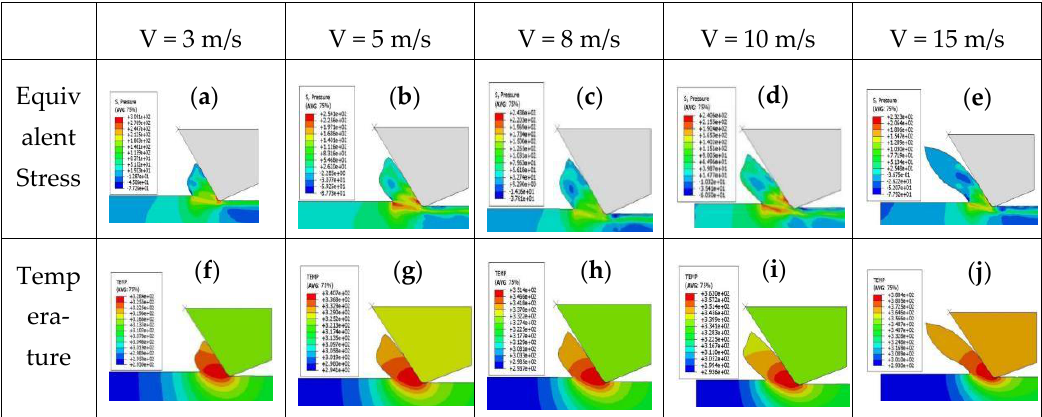
Figure 8. Stress distribution and temperature distribution of KDP crystal at different cutting speeds with unformed chip thickness of 429 nm: ( a )Equivalent Stress of V = 3 m/s; ( b )Equivalent Stress of V = 5 m/s; ( c )Equivalent Stress of V = 8 m/s; ( d )Equivalent Stress of V = 10 m/s; ( e )Equivalent Stress of V = 15 m/s; ( f )Temperature of V = 3 m/s; ( g )Temperature of V = 5 m/s; ( h )Temperature of V = 8 m/s; ( i )Temperature of V = 10 m/s; ( j )Temperature of V = 15 m/s.